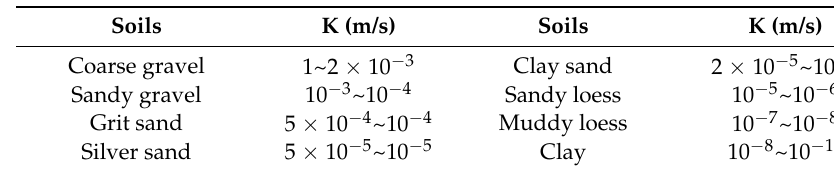
Table 1. Empirical values of hydraulic conductivity.